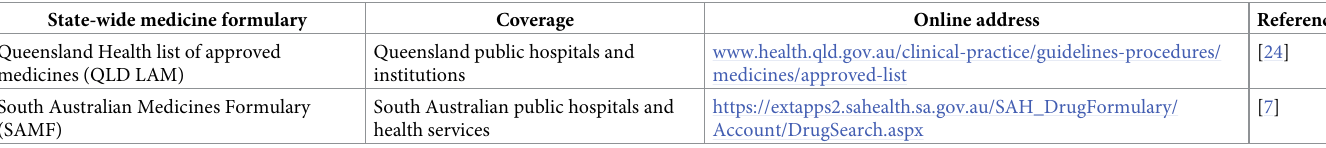
Table 3. Publicly available state-wide medicine